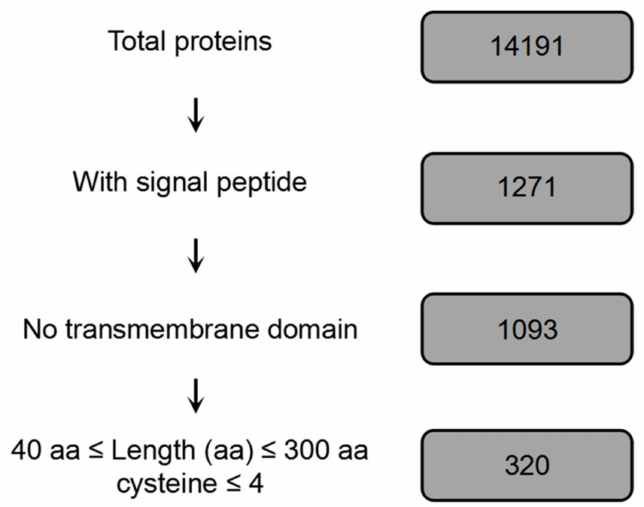
Figure 1. Pipeline for B. dothidea candidate effector proteins